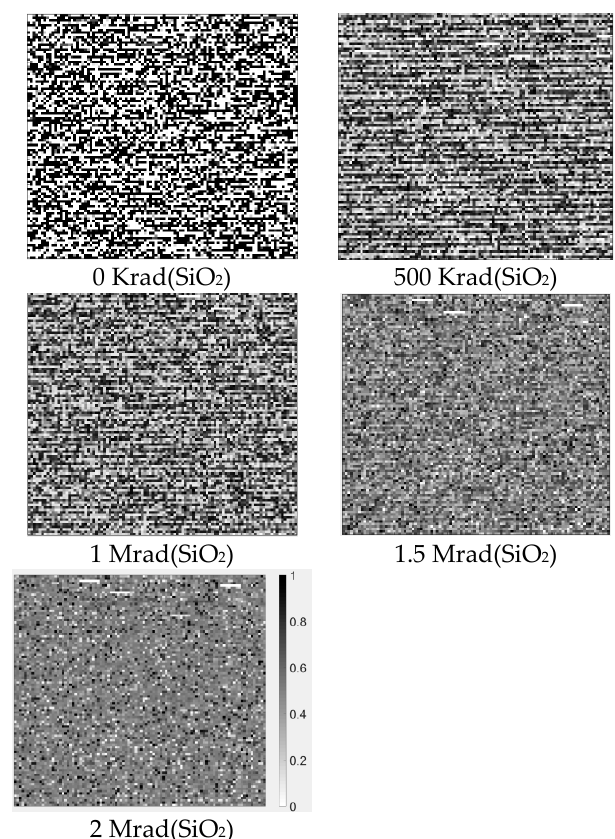
Figure 5. P0 of SRAM cells in Chip #4 under different doses. The darker the grid, the higher probability of the corresponding cell being initialized to ‘0 ′ .